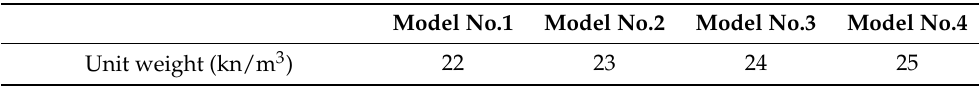
Table 12. Different unit weight value models.